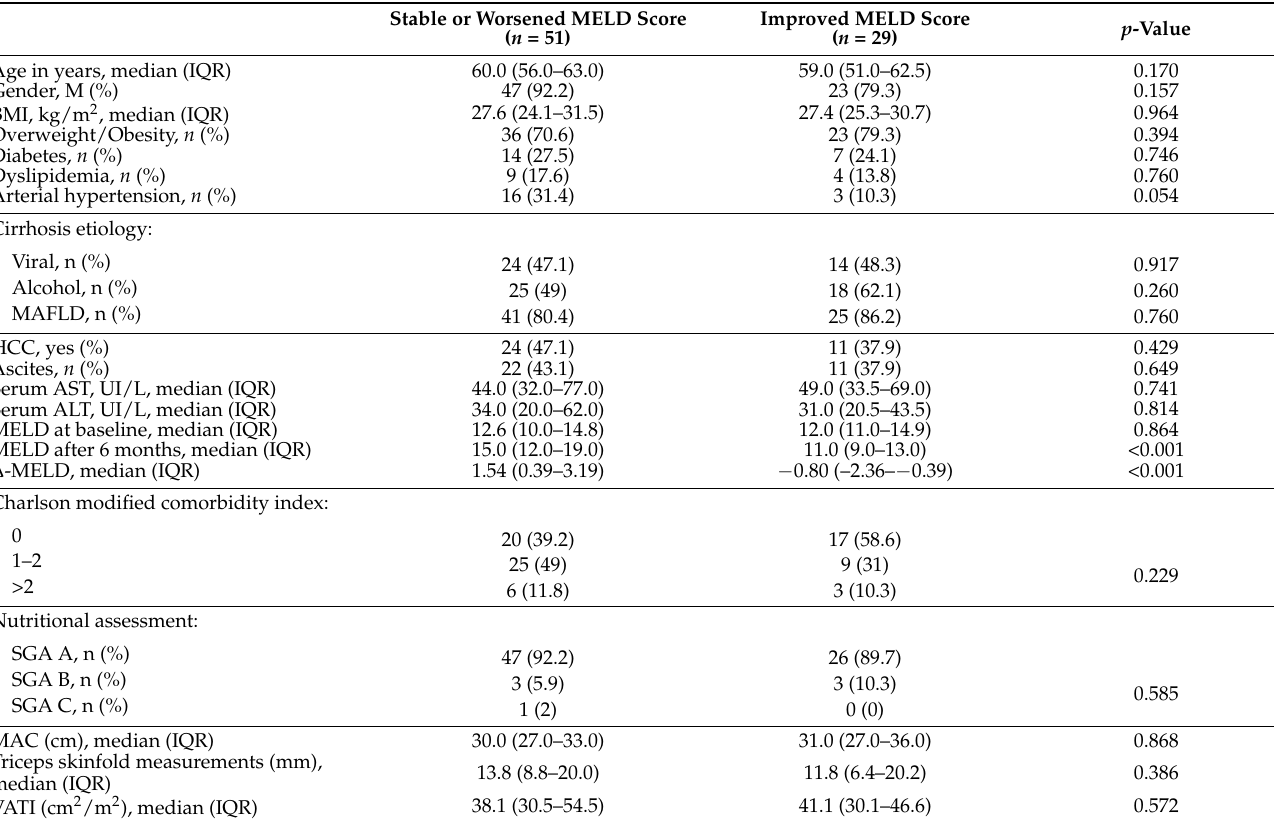
Table 2. Demographic, clinical, and nutritional characteristics of patients with cirrhosis subgrouped according to their MELD score changes over time. Stable or Worsened MELD Score Improved MELD Score p ( n = 51) ( n = 29)